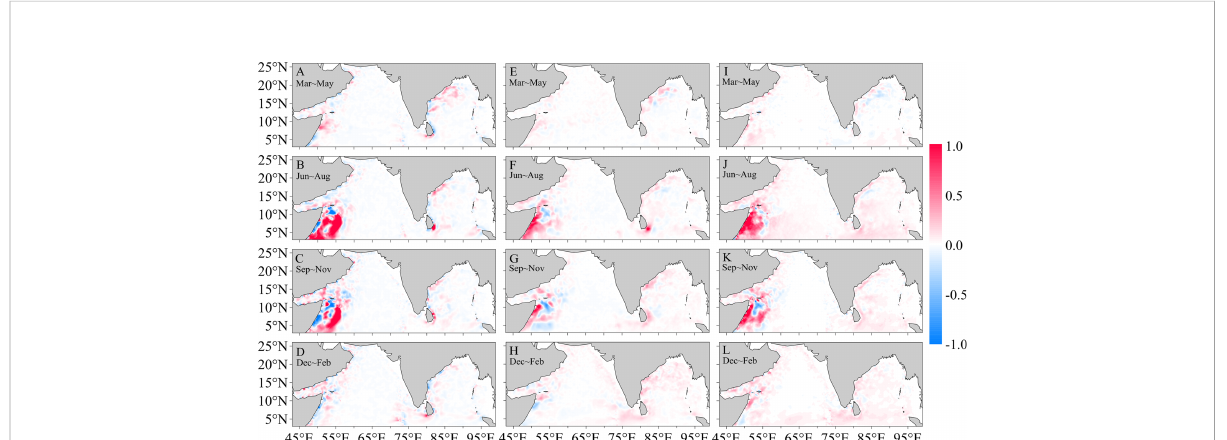
FIGURE 5 Seasonal distribution of T4 (A-D) and T2 (E-H) and energy conversion between eddy potential energy (EPE) and eddy kinetic energy (EKE) (I-L) averaged from the surface to 200 m in spring, summer, autumn, and winter (unit: 10 -7 m 2 ·s -3